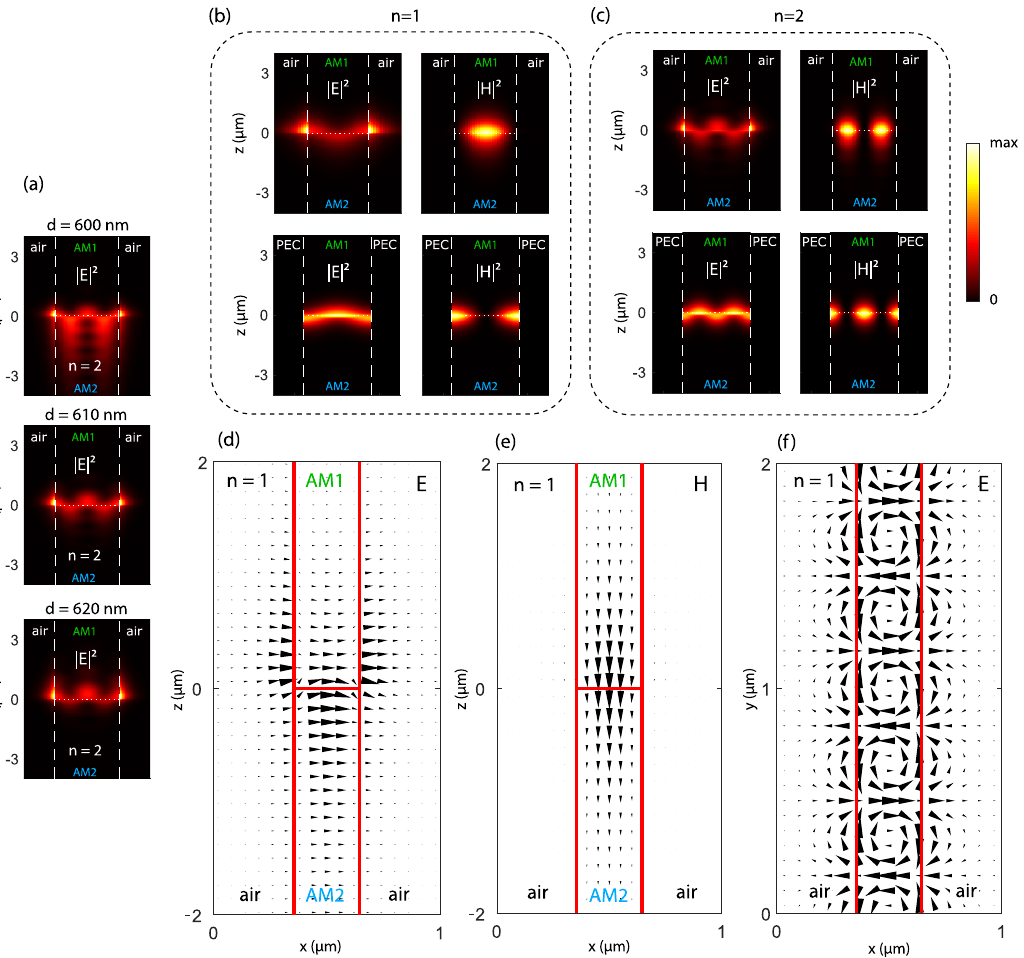
Figure 4: (Color online) (a) Electric field intensity profiles in xz cross-section in the second-order DSWM calculated for different waveguide widths. (b, c): Electric fi eld intensity pro fi les in xz cross-section in the fi rst-order and the second-order DSWMs calculated for the air and PEC boundaries. Calculations are made for d (cid:1) 290 nm, k y (cid:1) 9 . 429 μ m − 1 (air, n (cid:1) 1); d (cid:1) 320 nm, k y (cid:1) 9 . 786 μ m − 1 (PEC, n (cid:1) 1); d (cid:1) 610 nm, k y (cid:1) 9 . 584 μ m − 1 (air, n (cid:1) 2); d (cid:1) 640 nm, k y (cid:1) 9 . 786 μ m − 1 (PEC, n (cid:1) 2). Colorscale for panels (a – c) is shown on the right. (d – f) Electric and magnetic vectors in xz and xy cross-sections. The length of the triangles is proportional to the fi eld strength at the central point of each triangle. Triangles specify the corresponding electric fi eld direction by their orientation. White lines in a – c and red lines in d – f denote the material boundaries. All calculations are made for ε 1 (cid:1) 9, ε 2 (cid:1) 16, λ (cid:1) 1550 nm. DSWM, Dyakonov surface waveguide